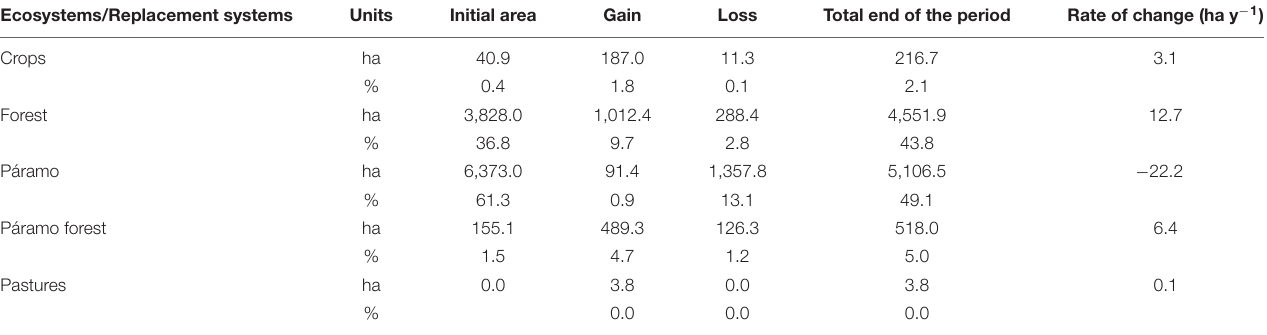
TABLE 2 | Total area and % gain and loss for each ecosystem at the Capaz study area during the whole period (57 years from 1952 to 2009).